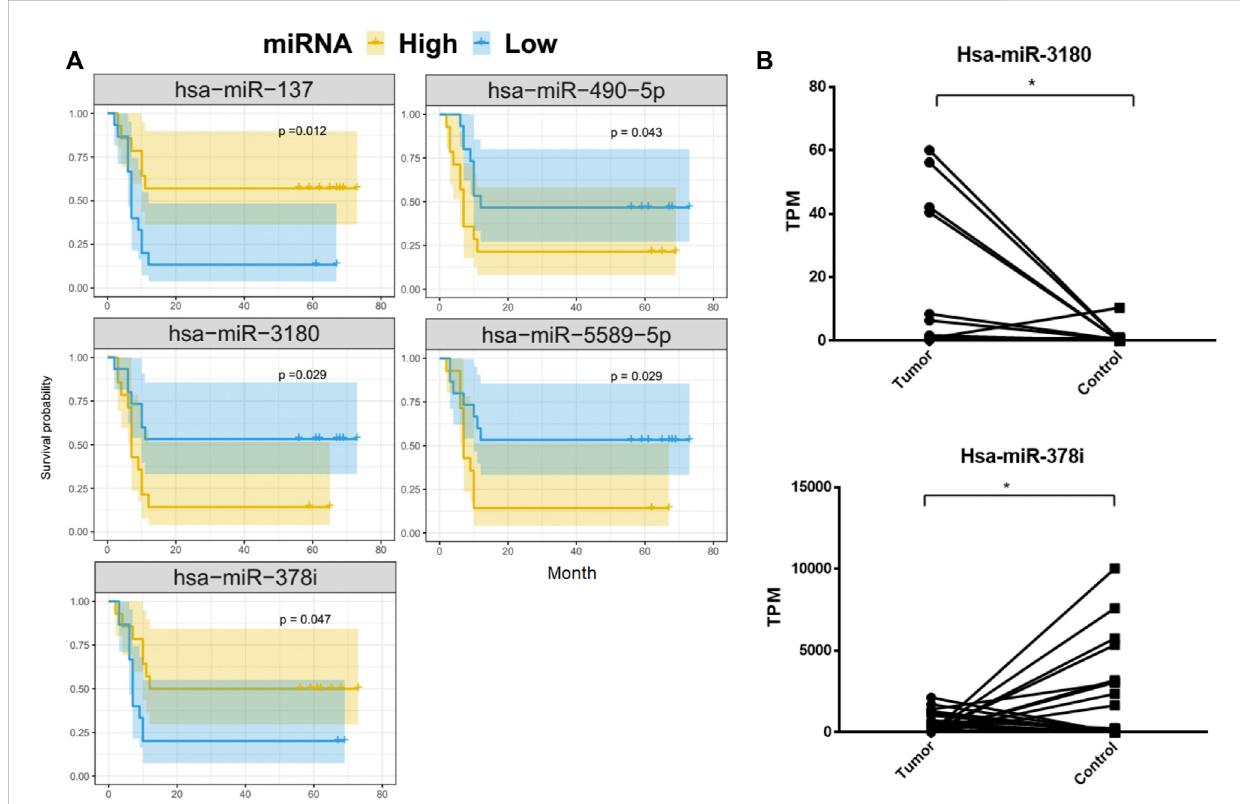
FIGURE 3 Kaplan-Meier overall survival curves for 32 HCC patients. Tumor miRNA expression was divided into two groups and the log-rank test was used to compare thesurvivalcurvesofthehigh- andlow-expression groups. (A) MiRNAs that weresigni fi cantly associated with overall survival. (B) Differences in the expression of hsa-miRNA-3180 and hsa-miRNA-378i between HCC and adjacent normal liver tissue from 32